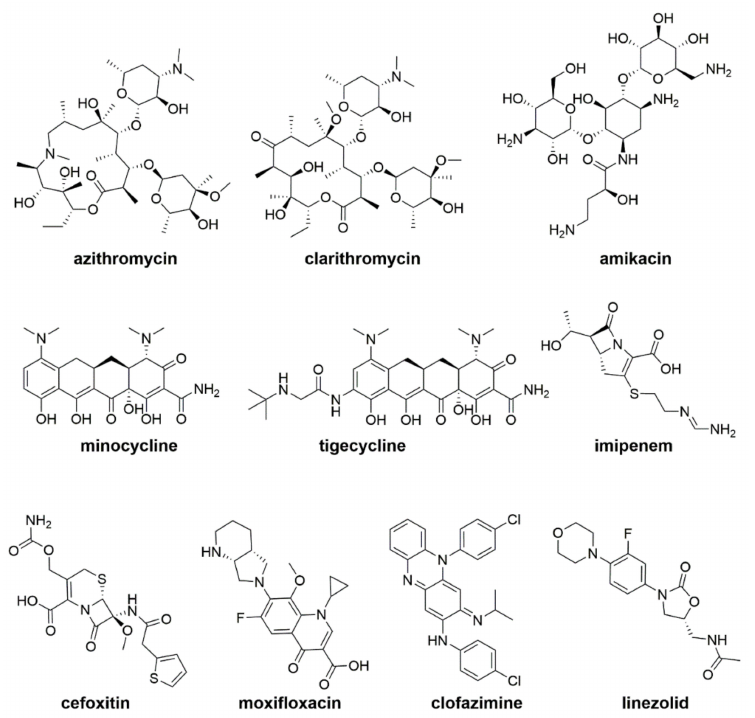
Figure 2. Drugs currently used in Mab